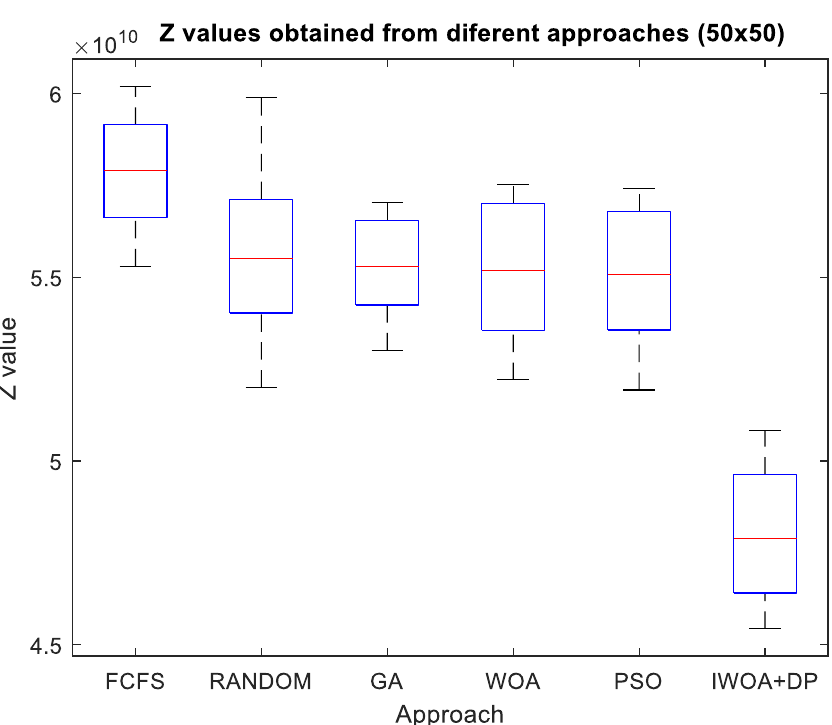
Figure 13. The box-whisker plot chart of Z values found for the problems (50 × 50).